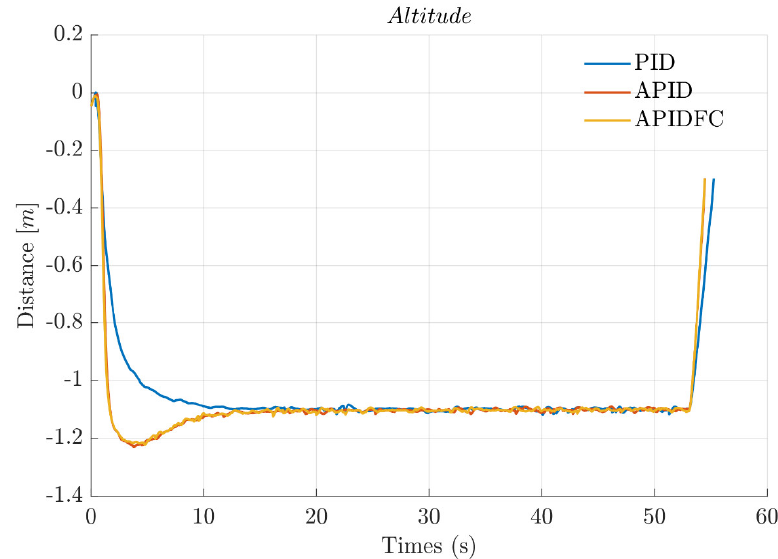
Figure 14. Altitude response comparison according to the experiments.